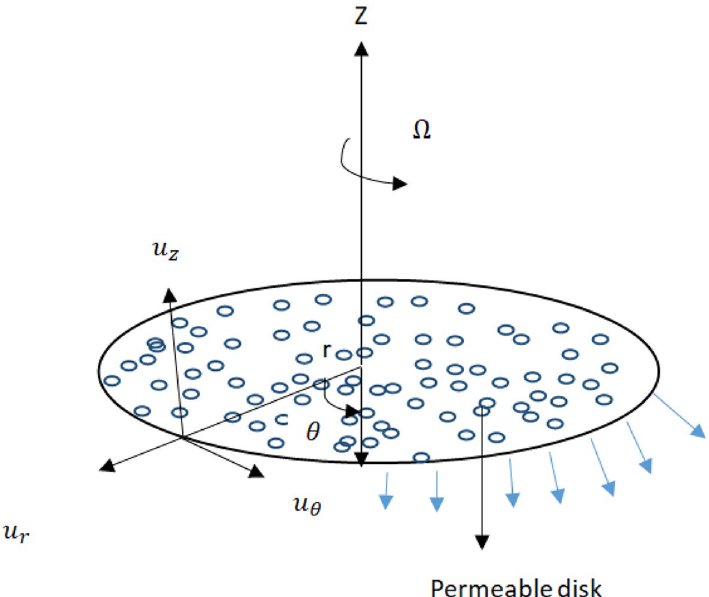
Figure 1. Geometry of